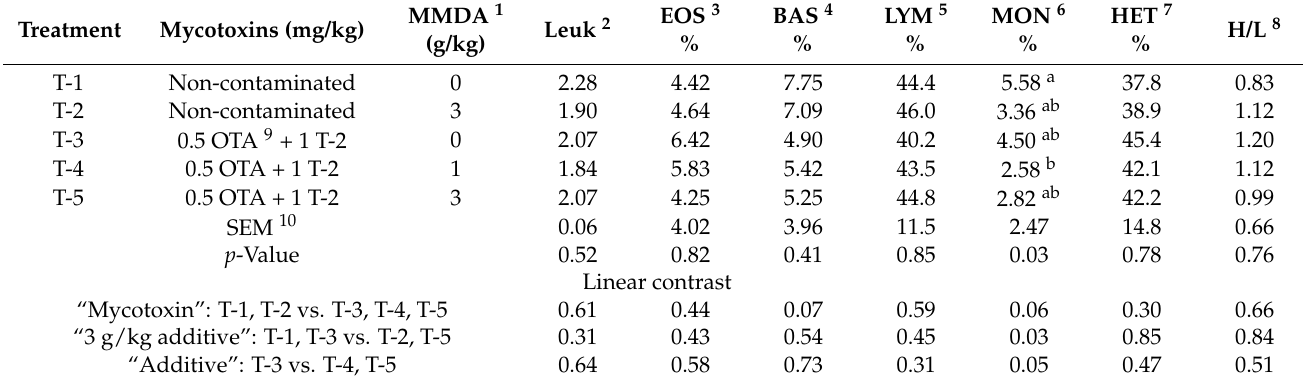
Table 6. The effects of feeding ochratoxin A (OTA) and T-2 mycotoxins and the addition of a binder mycotoxin product (MMDA) on blood hematology (leukogram) of broiler chickens.